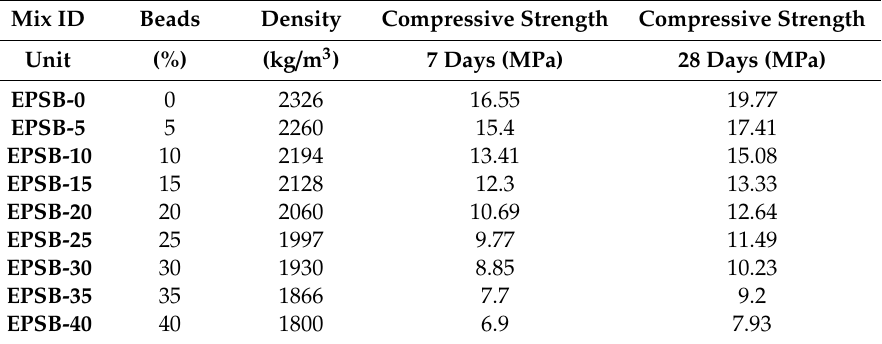
Table 8. Rebound hammer strength.